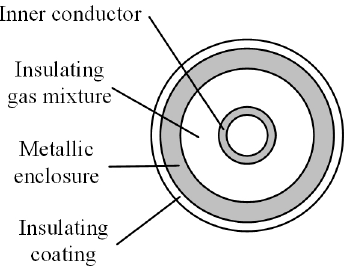
Figure 1. Geometrical structure of the gas-insulated line (GIL).